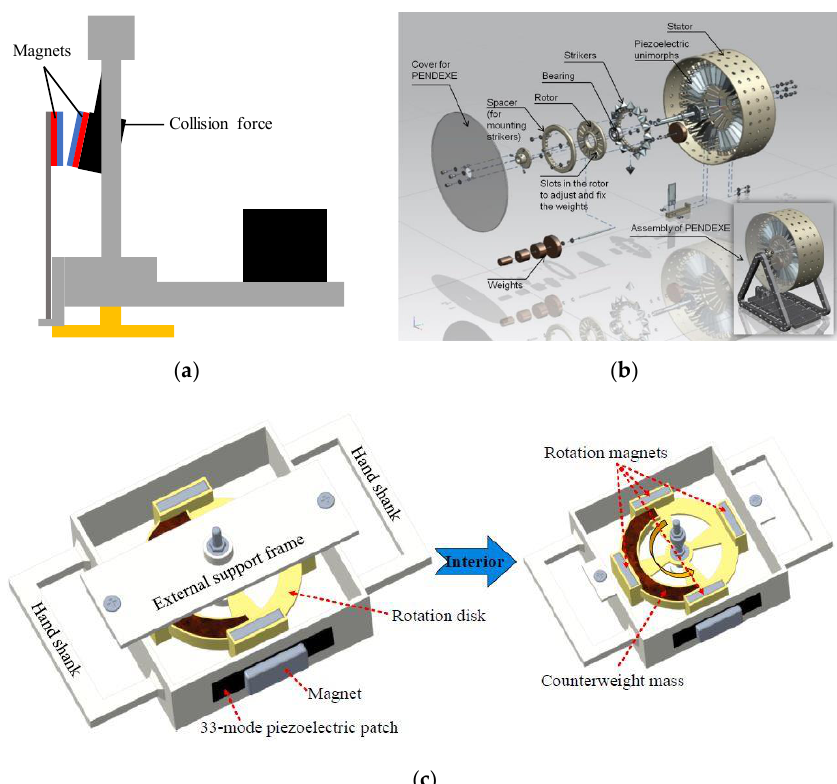
Figure 9. ( a ) Multi-directional pendulum kinetic energy harvester [80]. ( b ) Human waistline movement energy harvester [82]. Reprinted with permission from Ref. [82]. Copyright 2014, Elsevier. ( c ) Hand-held human motion energy harvester [83].